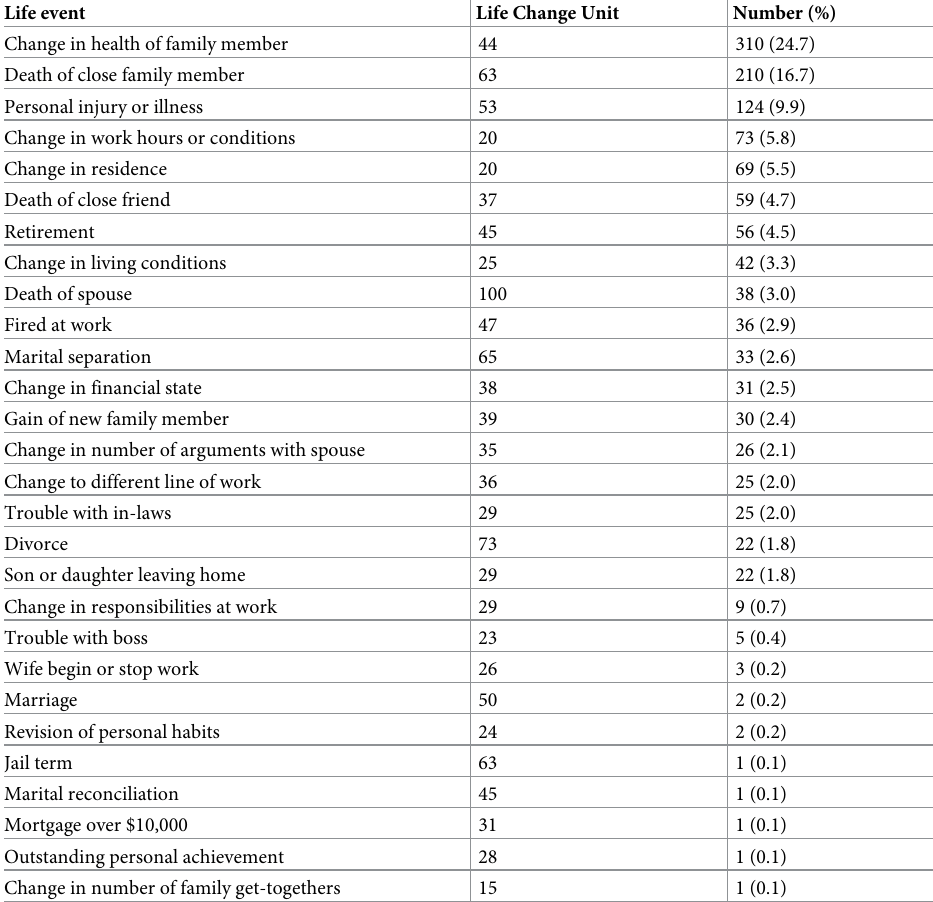
Table 1. Frequency of important life events according to the